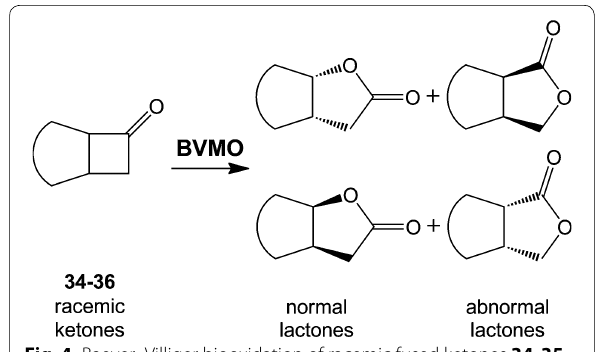
Table 4 Biooxidation of fused cyclobutanones mediated by BVMO No